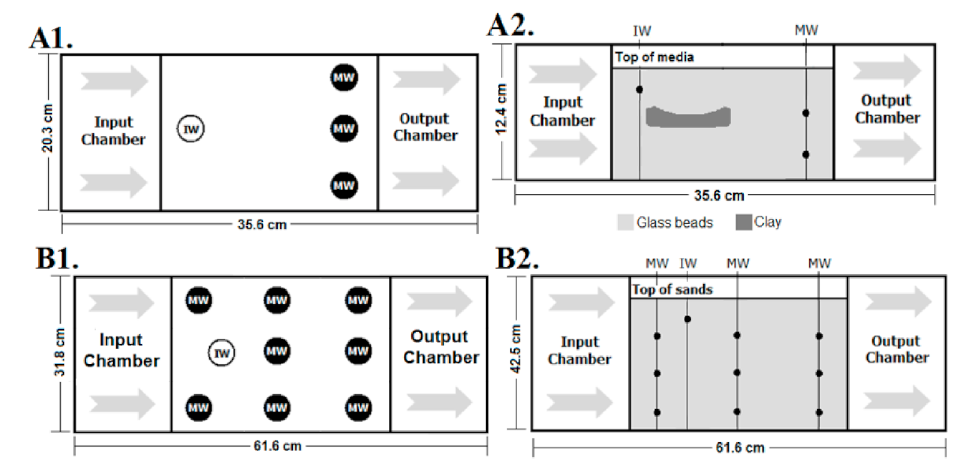
Figure 1. Schematics of the set-up for flow tank experiments with monitoring well (MW) and injection well (IW) locations. Note: Not drawn to scale. ( A1 ) Aerial view of small flow tank. ( A2 ) Cross-sectional view of small flow tank with clay lens and sampling locations at varying depths. ( B1 ) Aerial view of large flow tank. ( B2 ) Cross-sectional view of large flow tank with sampling locations at varying